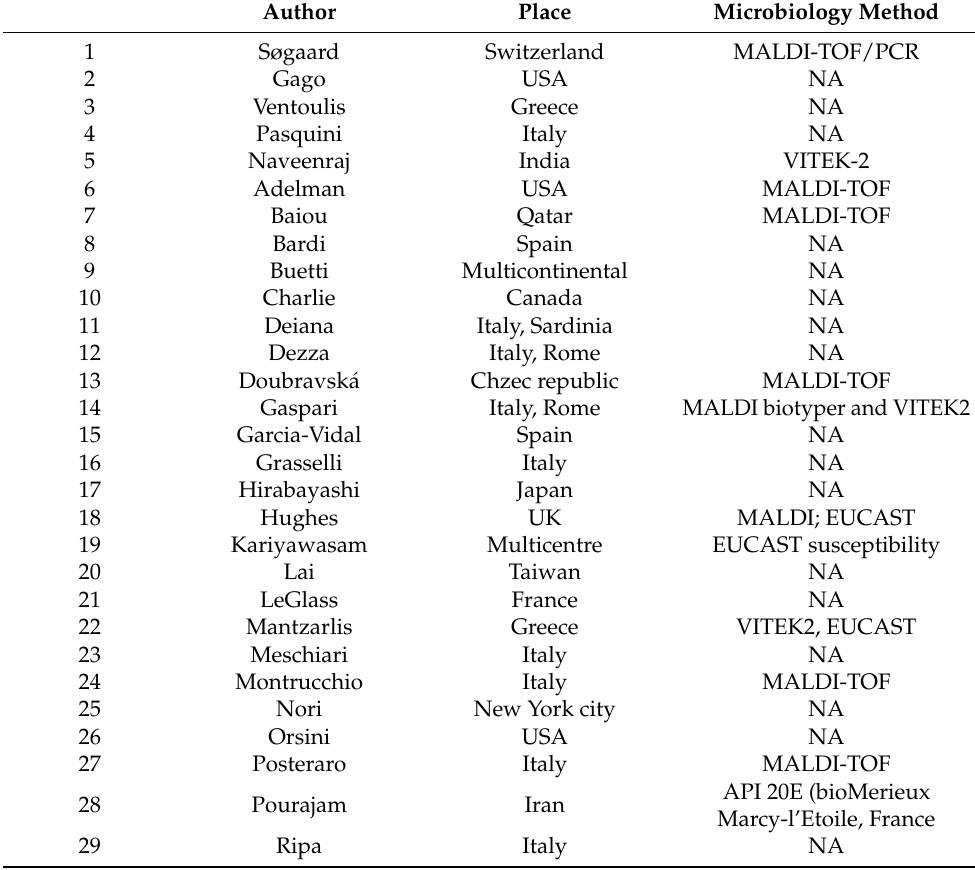
Figure 1. Flowchart of paper selection. Table 1. Summary of the studies included in relation to country and the microbiological methods used to identify Pseudomonas aeruginosa